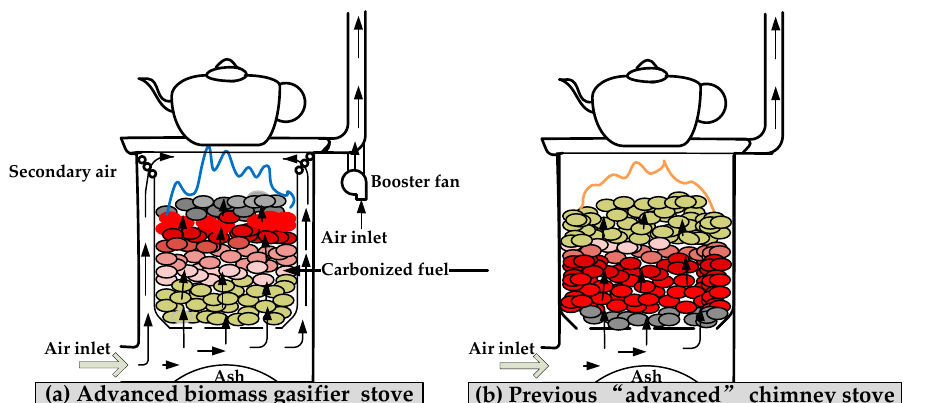
Figure 1. Schematic diagram of the stove used in the experiment: ( a ) advanced biomass gasifier stove and ( b ) traditional chimney stove.